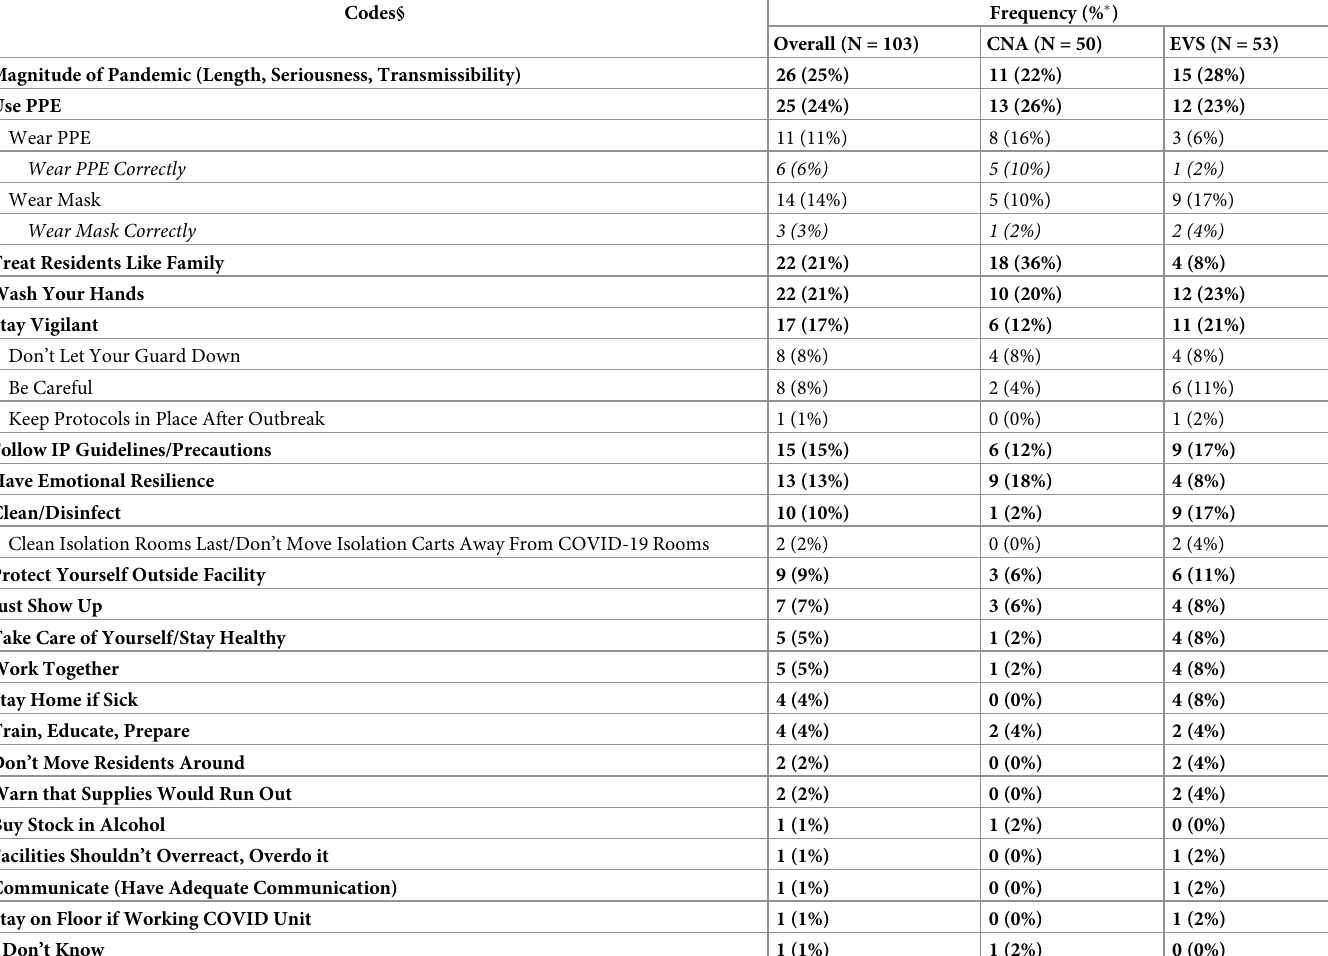
Table 5. Frequency of qualitative codes by theme: What do you wish you would have known? what piece of advice would you share with another CNA/EVS staff member about COVID-19?.